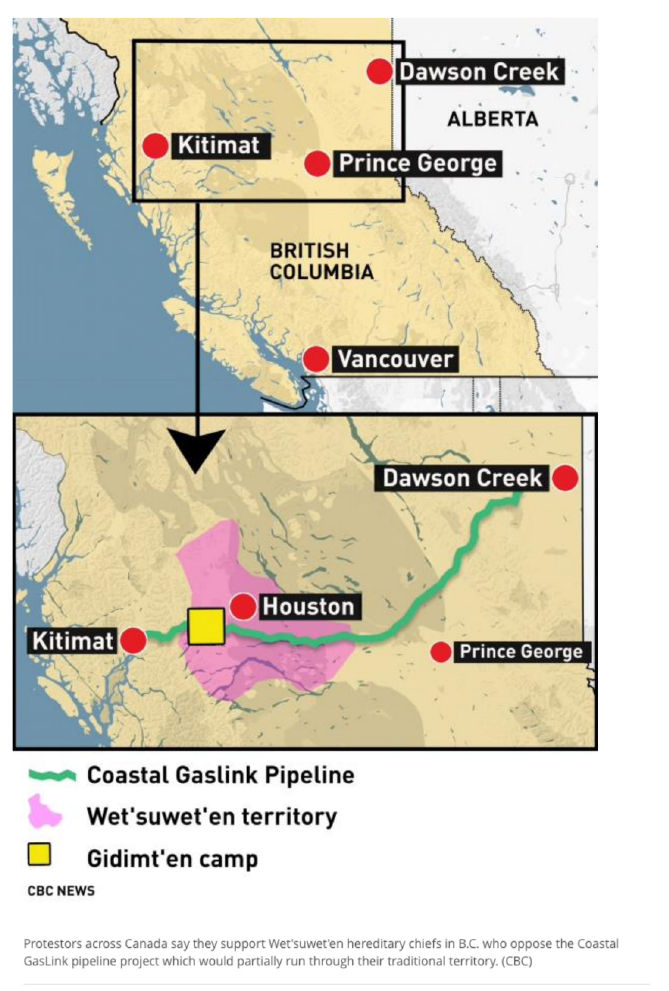
Figure 2: CBC News’ Wet’suwet’en map. Source: https://www.cbc.ca/news/indigenous/blockade-railway-mowhak-wet-suwet-en-1.5467234. Image reproduced under the Fair Use